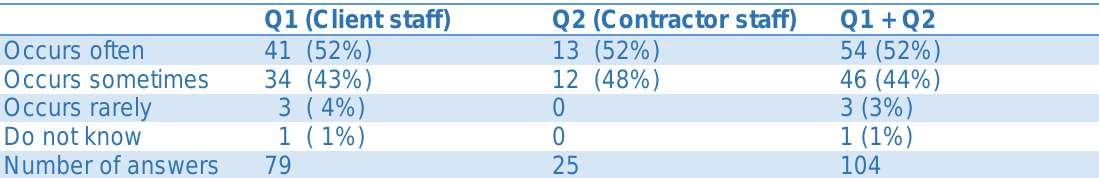
Table 2: Question. What is your view on the prevalence of cost overruns in infrastructure projects?